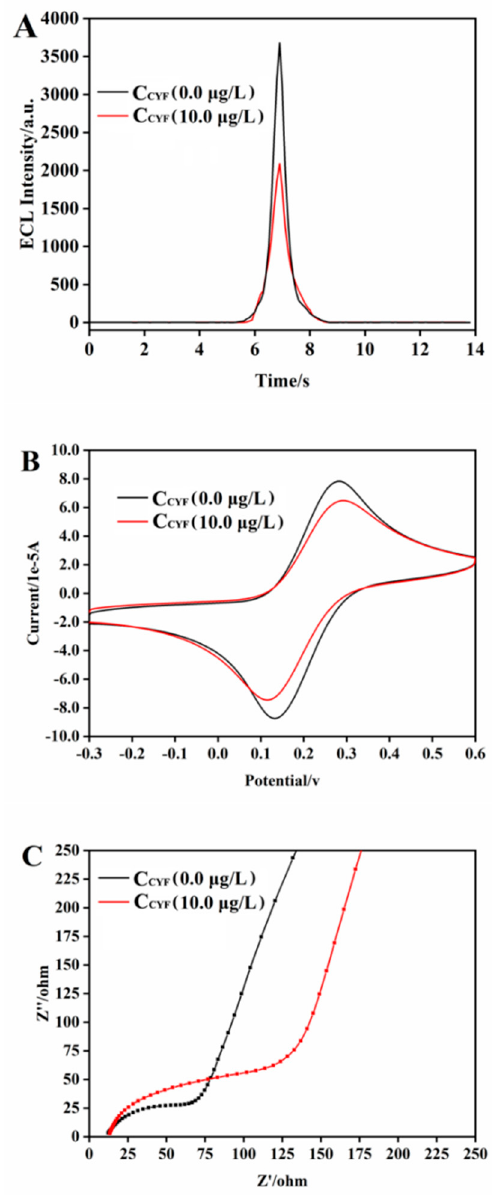
Figure 4. ( A ) ECL curves, ( B ) Cyclic voltammograms and ( C ) EIS curves of Nafion-MWCNTs/MIP- QDs/GCE, before and after adding CYF. CYF concentration (C CYF ): 10.0